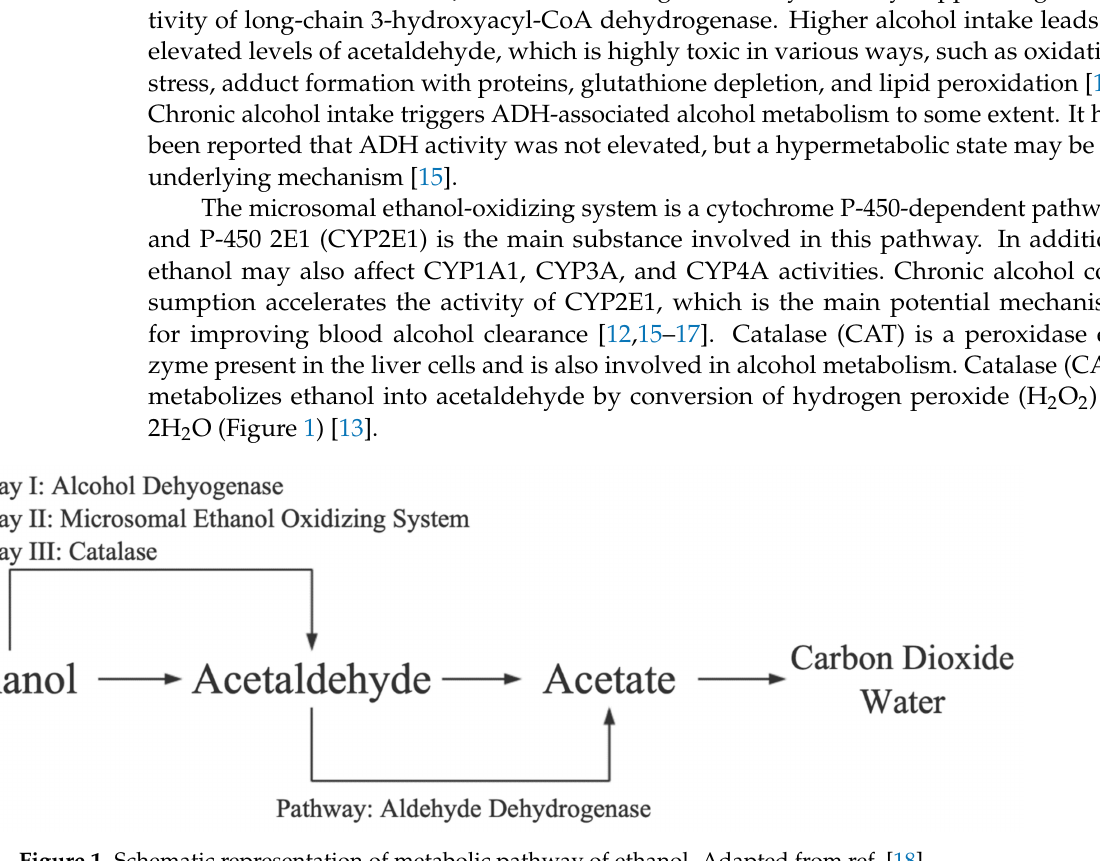
Figure 1. Schematic representation of metabolic pathway of ethanol. Adapted from ref.